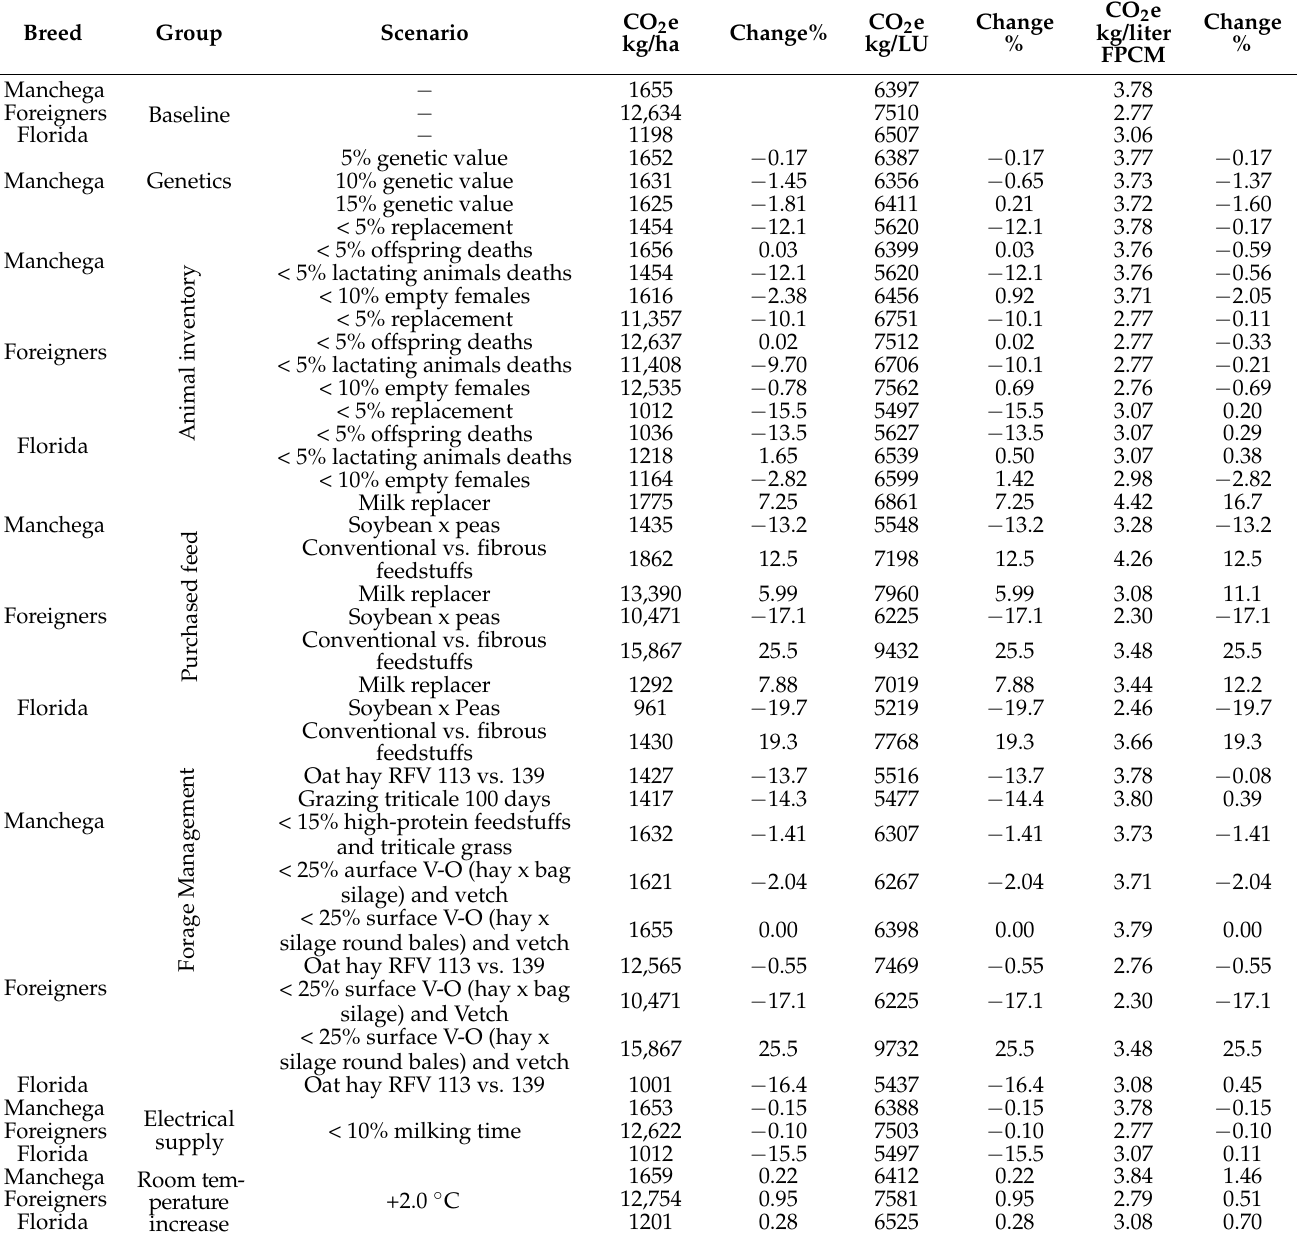
FPCM: Fat- and protein-corrected milk; RFV: Relative forage value; V-O: